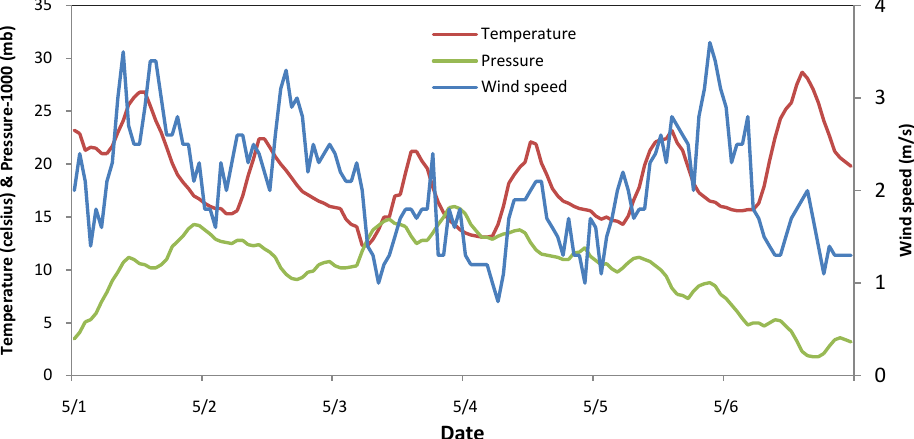
Fig. 7. Surface meteorological variables from 1 to 6 May in the Shanghai monitoring site. Fig.7. Surface meteorological variables from May 1 to 6 in Shanghai monitoring site